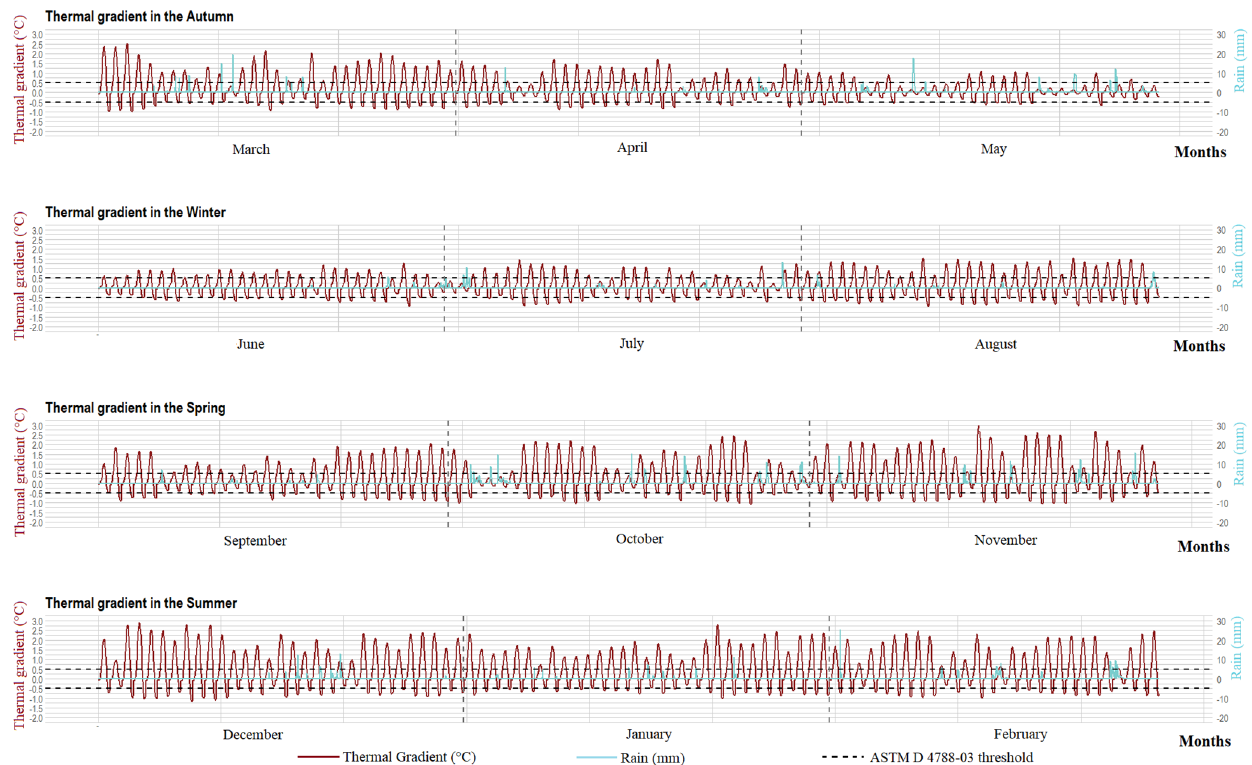
Figure 7. Thermal gradient results from the FEM simulation of one year of IRT inspection.